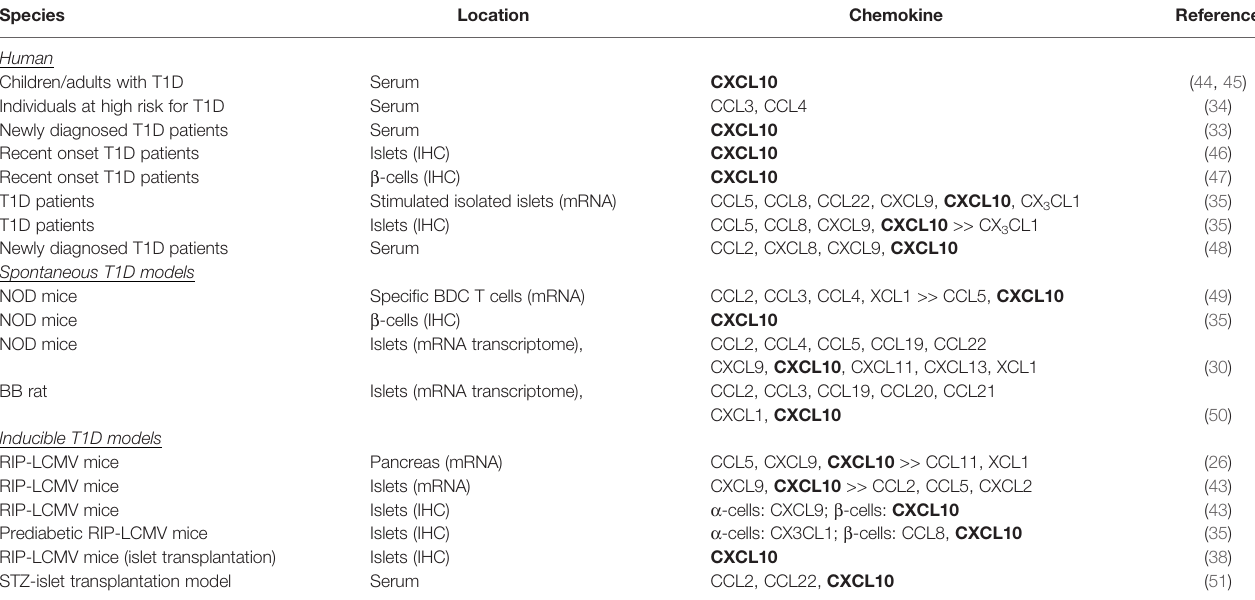
TABLE 1 | Chemokine expression in T1D patients and experimental animals.